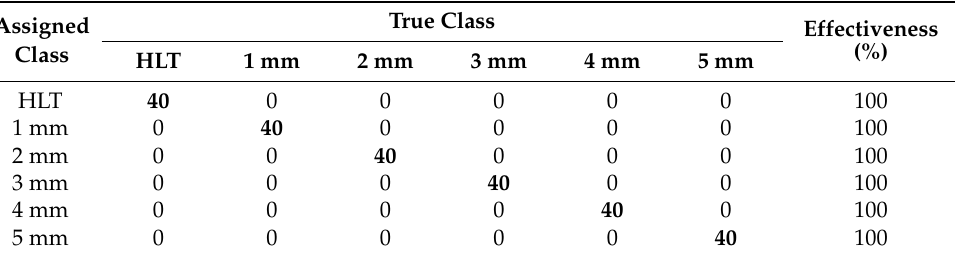
Table 5. Effectiveness percentage of the proposed methodology (confusion matrix) when analyzing all considered bearing conditions for a direct line power supply at 60 Hz, and for a VFD power supply of 60 Hz, 50 Hz and 15 Hz.